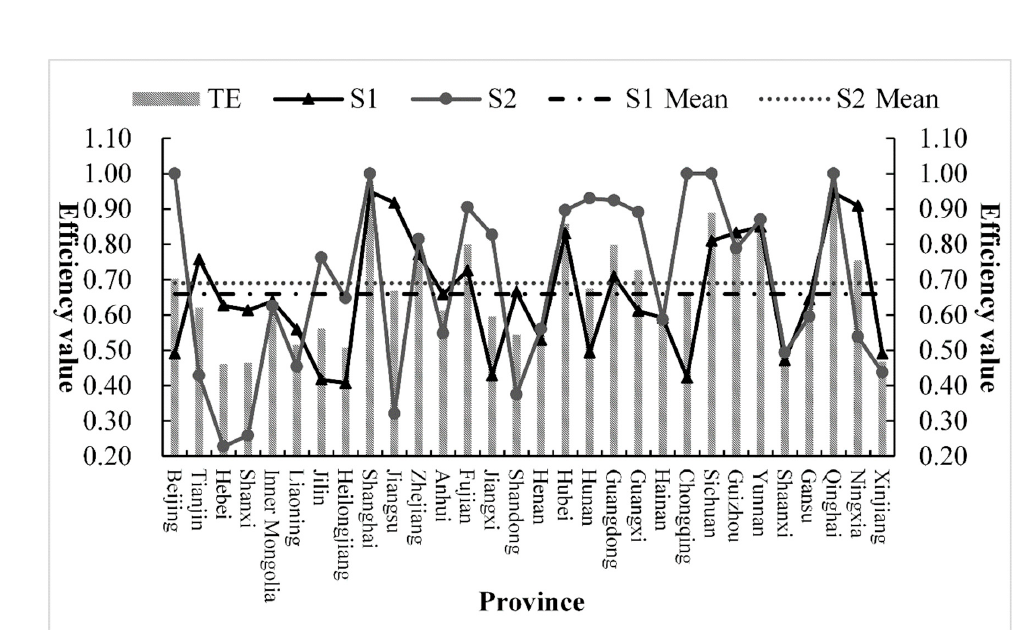
Figure 3. Comparative trend of environmental efficiency of power industry in 30 Provinces in China. Note: TE represents the overall efficiency; S1 represents the power generation efficiency of the first link; S2 represents the power transmission and distribution network efficiency of the second link.